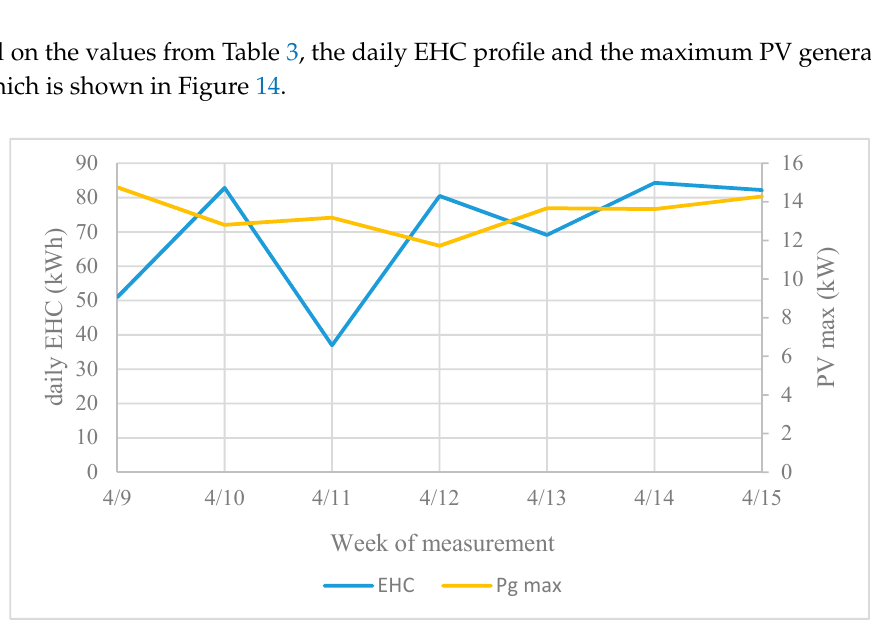
Figure 15. The Weekly Dynamic Hosting Capacity Profile.